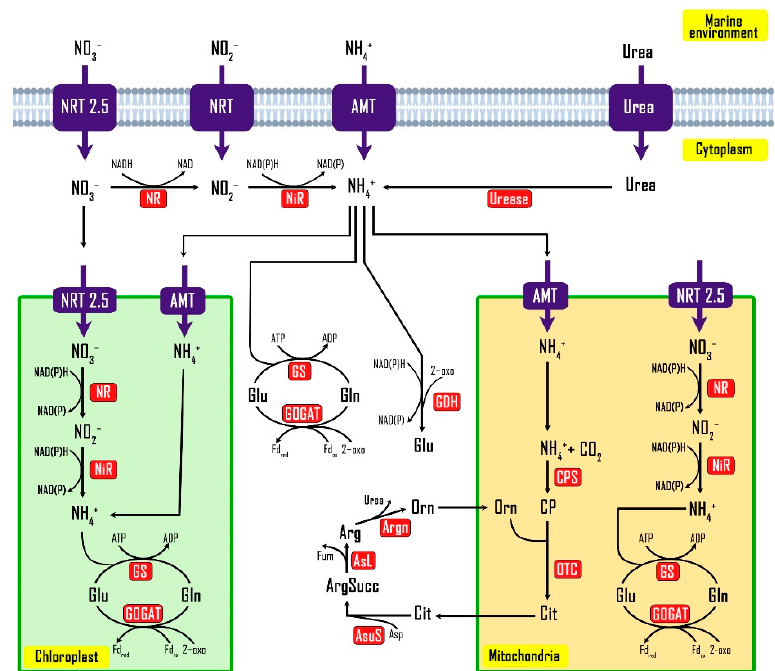
Figure 5. A model for the subcellular localization and metabolic pathway of nitrogen metabolisms by A. minutum . The full names of the proteins within the figure legend are available in (Supplementary Material Table S4).